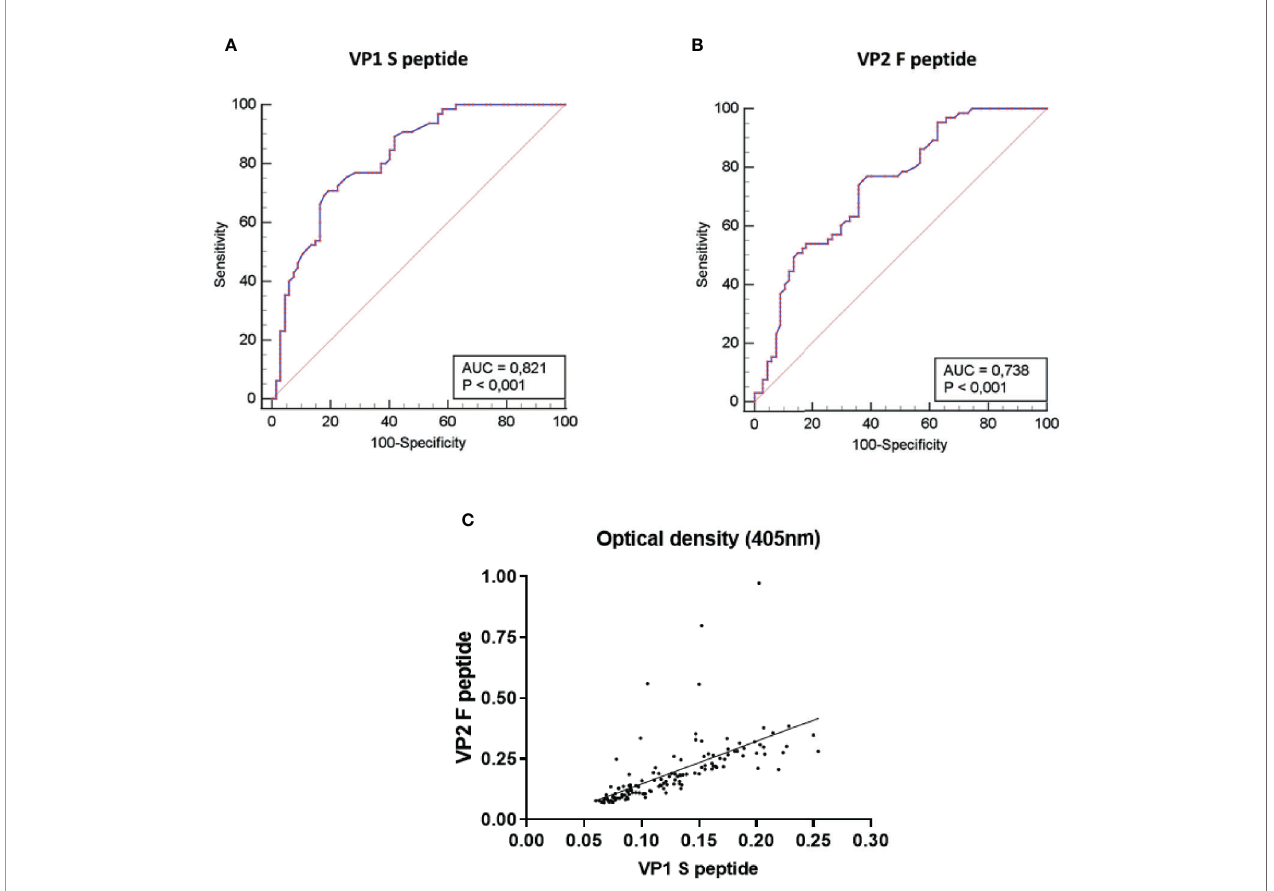
FIGURE 2 | Receiver-operator characteristic (ROC) curves and correlation of Optical density (OD) values of the indirect ELISA. ROC curves were built based on optical density (OD) values obtained on MCPyV-negative (n=67) and -positive (n=65) control sera, for both MCPyV VP1 S and VP2 F peptides. The values for the area under the ROC curve (AUC) were 0.821 for VP1 S peptide (A) and 0.738 for VP2 F peptide (B) . The diagonal line shows an AUC value of 0.5 which is representative of a worthless test. The difference between AUCs for both S and F peptides resulted statistically signi fi cantly different from that of a worthless test (AUC=0.5, P<0.001). (C) The concordance in ODs between the S and F peptides was evaluated on the entire set of MCPyV-negative/-positive control sera (n=132) using Spearman correlation analysis. Concordance between VP1 S peptide and VP2 F peptide was good, with an r of 0.8723 and a